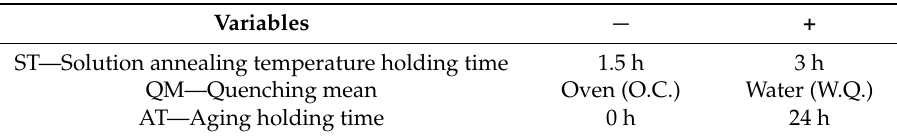
Table 2. Variables and experimental parameters.